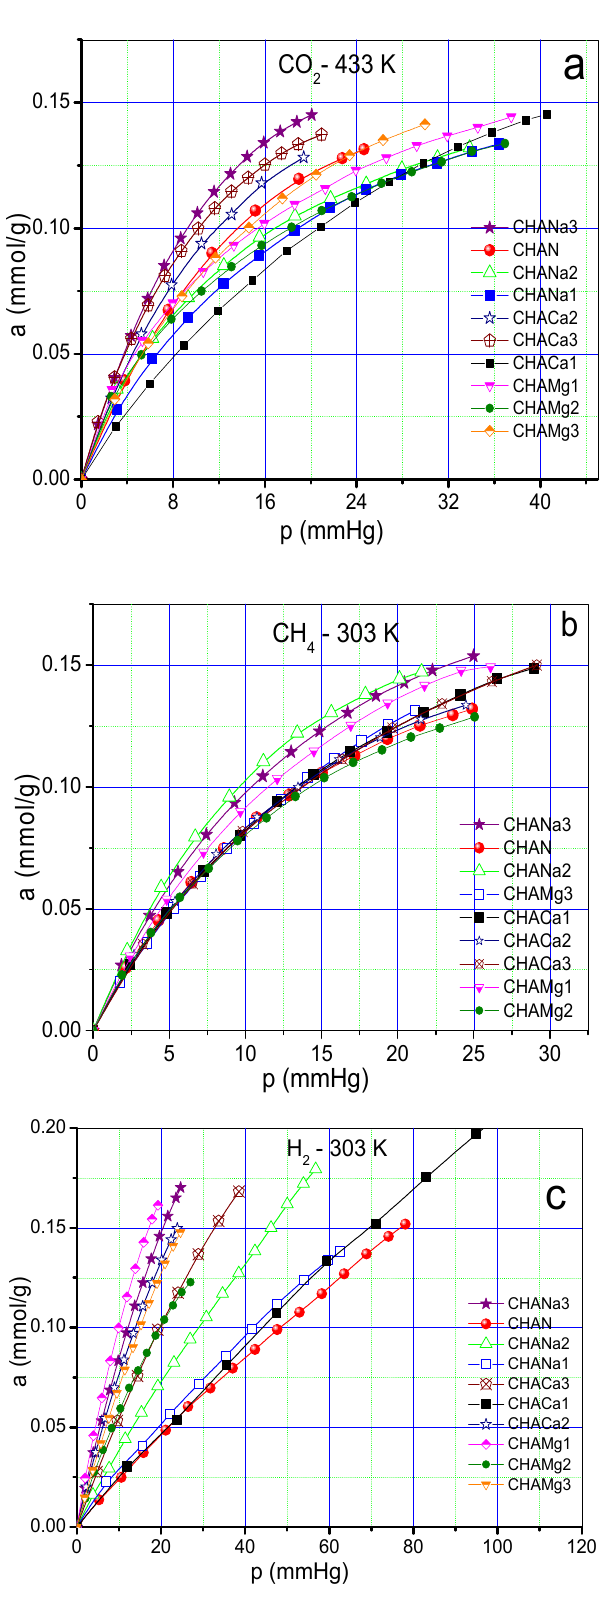
Figure 7. ( a ) Adsorption isotherm of CO 2 on chabazite zeolites at 433 K. ( b ) Adsorption isotherm of CH 4 on chabazite zeolites at 303 K ( c ). Adsorption isotherm of H 2 on chabazite zeolites at 303 K.